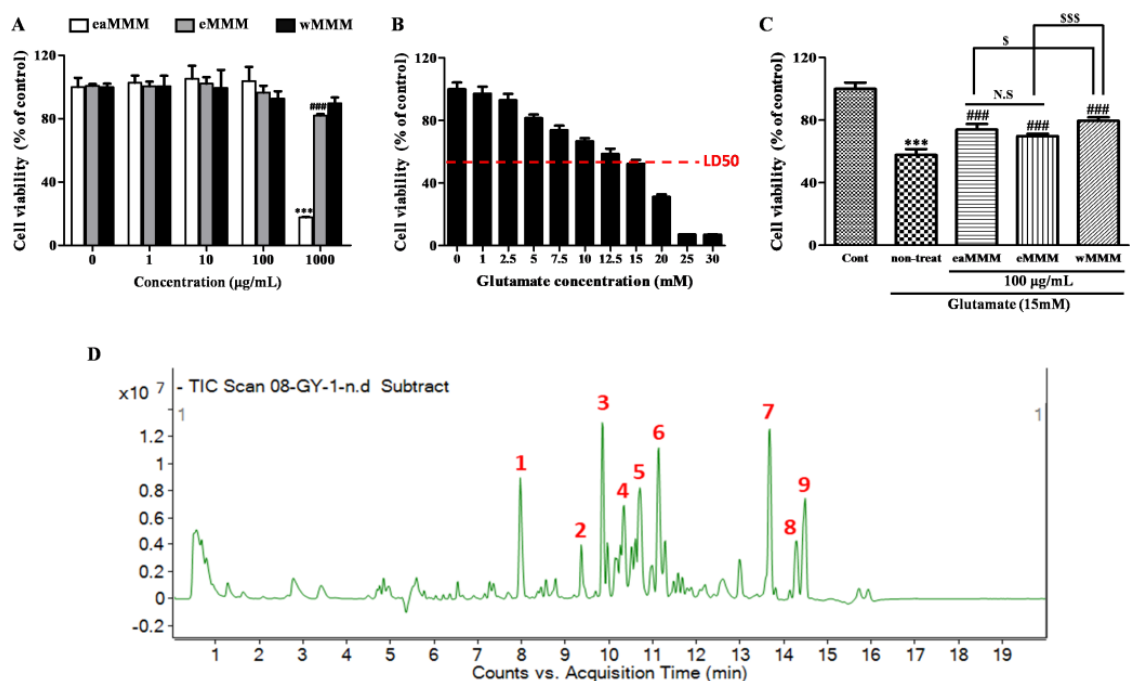
Figure 2. Selection of water extracts of mixed mushroom mycelia (wMMM) as a feasible form of MMM with the highest biosafety and neuroprotective efficacy and chemical profiling. In order to evaluate the biosafety of w-, ethanolic-(e-), and ethyl acetate-extract-(ea-) MMM, ( A ) the cell viabilities of PC-12 cells following incubation with the varying concentrations